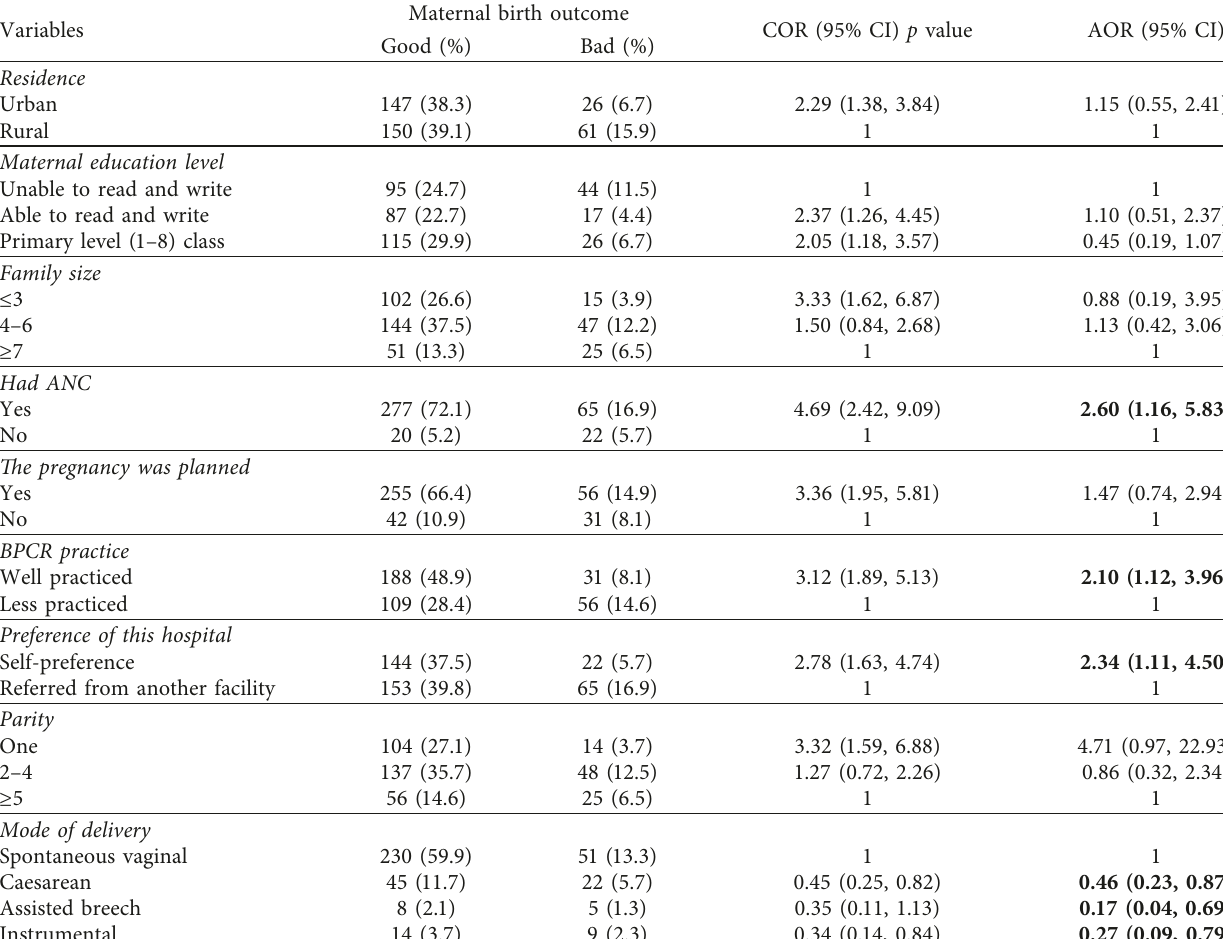
Table 3: Sociodemographic and obstetric factors associated with maternal birth outcome, among postnatal mothers in Debre Tabor Hospital, 2016 ( n �